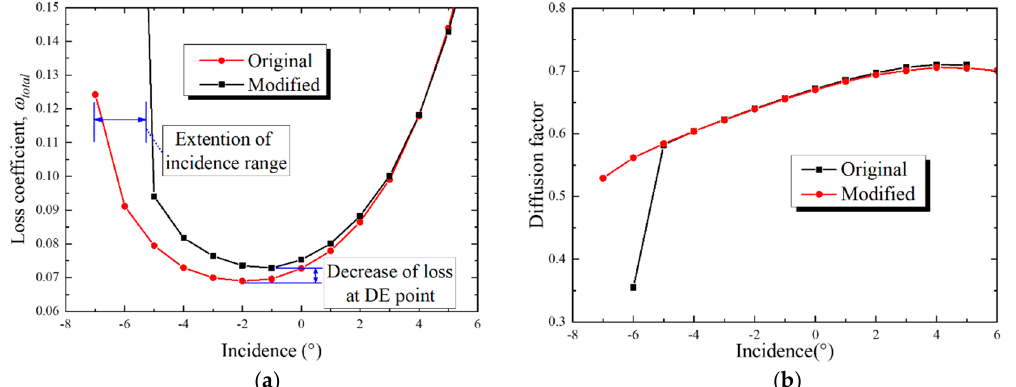
Figure 17. Comparison of baseline and optimized blade performances. ( a ) Incidence—loss coefficient; ( b ) incidence—diffusion